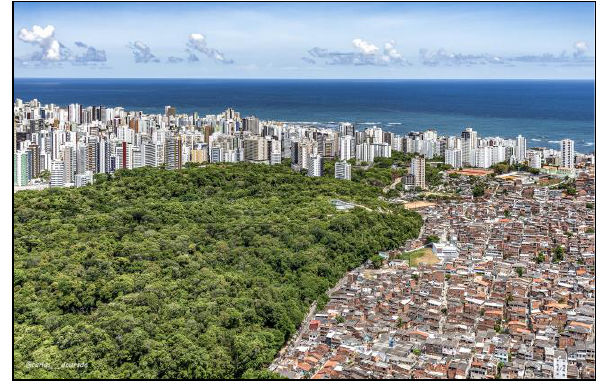
Figure 2. Socio-spatial segregation between construction types in two major neighborhoods in the city. The noble neighborhood Pituba and Santa Cruz neighborhood, demarcated by the Parque da Cidade in the center of the image. Fonte: (Carlos Dourado, 2019).